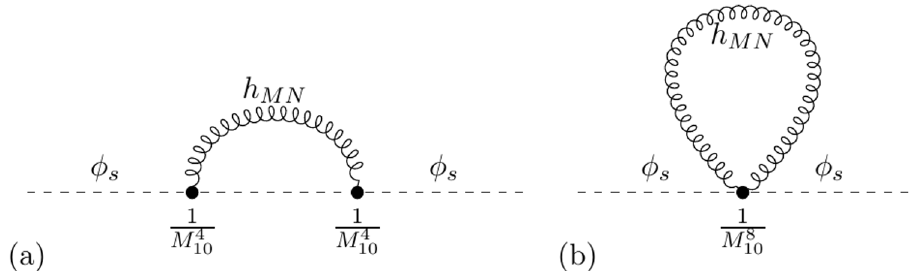
Figure 5 . Self-energy (a) and tadpole (b) loop diagram correcting the kinetic term of the scalar field φ s . The scalar is confined to a 4d submanifold whereas the graviton h MN propagates in